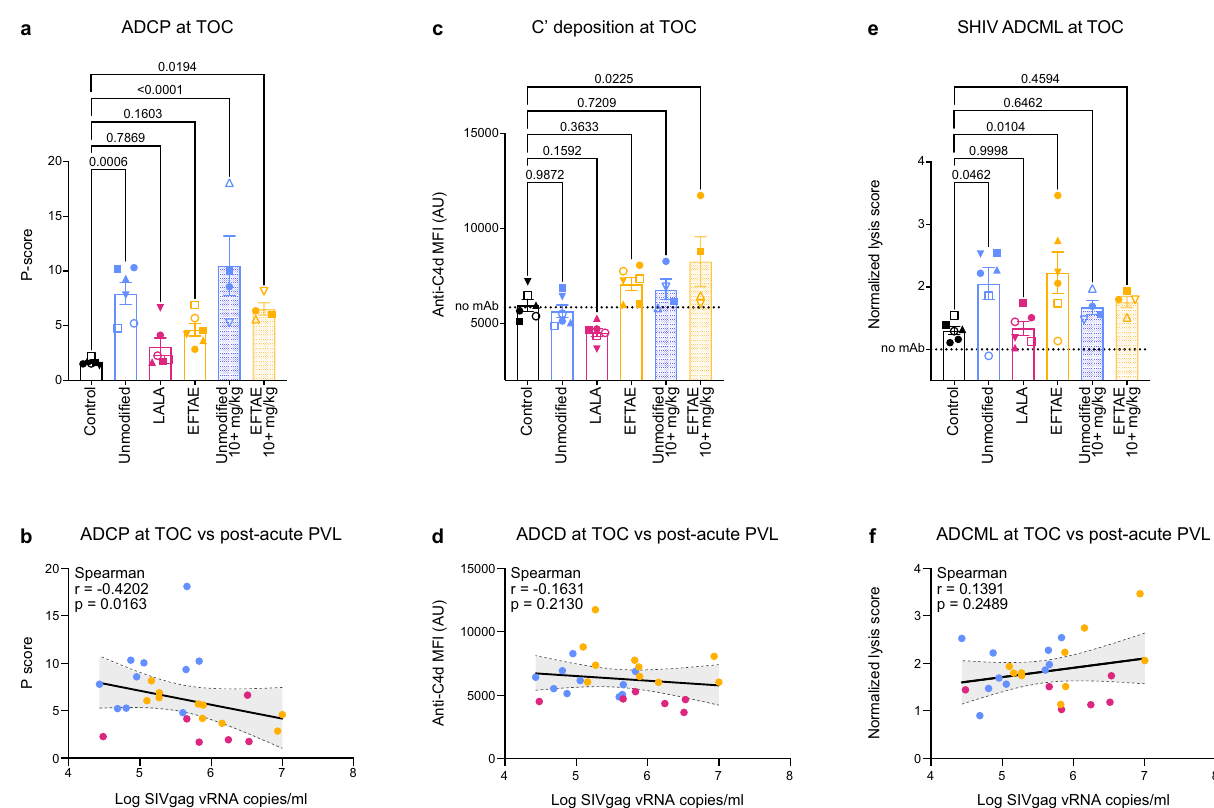
Fig. 6 Effector activity in plasma at TOC. a Plasma ADCP activity determined by co-incubation with THP-1 monocytes and measured as internalization of MPER-coated fl uorescent beads. c C3b deposition to plasma antibody complexed with MPER-coated beads measured by SPR. e C ’ -mediated lysis of SHIV SF162P3 virions incubated with heat-inactivated plasma supplemented with normal serum. Error bars in a , c , and e represent average values ± se with p values from one-way ANOVA followed by Dunnett ’ s post-hoc test. b , d , f Correlation matrices between the indicated effector function and post-acute PVL for each individual 10E8v4-treated macaque, with r and p calculated from one-tailed Spearman tests. Error band denotes best fi t values± se with 95% con fi dence intervals. Symbols for animal IDs in a , c , and e are the same as those shown in Figs. 4 and 5. Data and analysis are derived from n = 6 animals per group (5 mg/kg); n = 4 animals per group (10 + mg/kg). Statistical signi fi cance was determined at the signi fi cant alpha level of 0.05 and performed in GraphPad Prism 9. Data are representative of at least two independent experiments. Source data are provided in the Source Data fi le associated with this manuscript. Animal symbols and group colors are consistent throughout the manuscript. ADCP antibody-dependent cellular phagocytosis, C ’